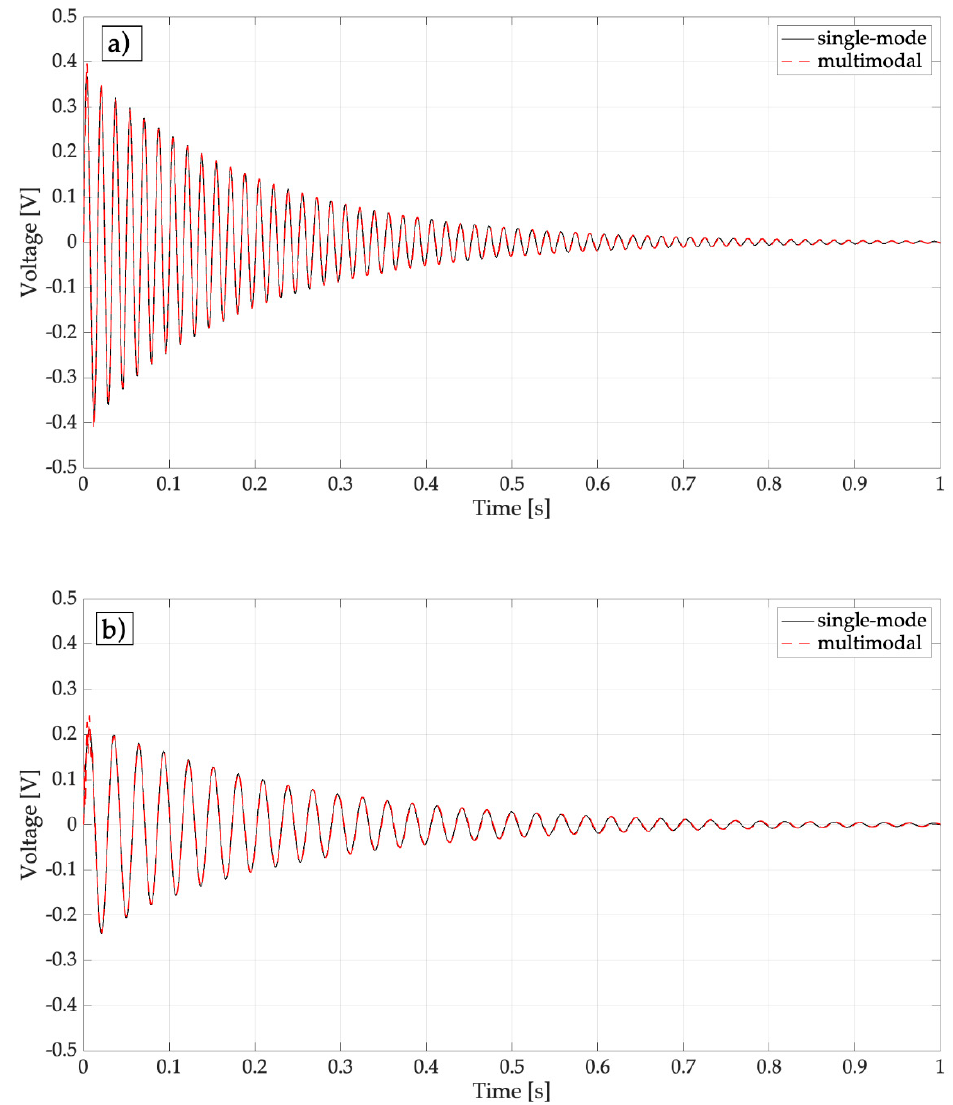
Figure 5. Effect of added mass on the peak-to-peak generated voltage: ( a ) Harvester with an empty spoon; ( b ) effect of the added water mass; single-mode: only the first-mode is considered, multimodal: the overall effect of the first three modes is considered.